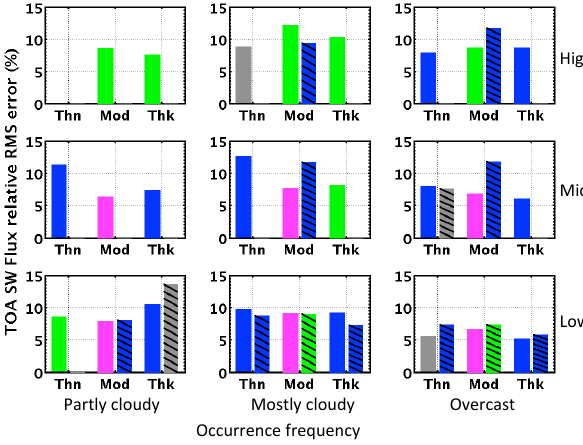
Figure 6. TOA SW flux consistency (%) between nadir- and oblique-viewing angles for different cloud types over ocean. The left bars are for single-layer clouds, and the right bars (hatched) are for multiple-layer clouds. The color of the bar indicates the occur- rence frequency for each cloud type.